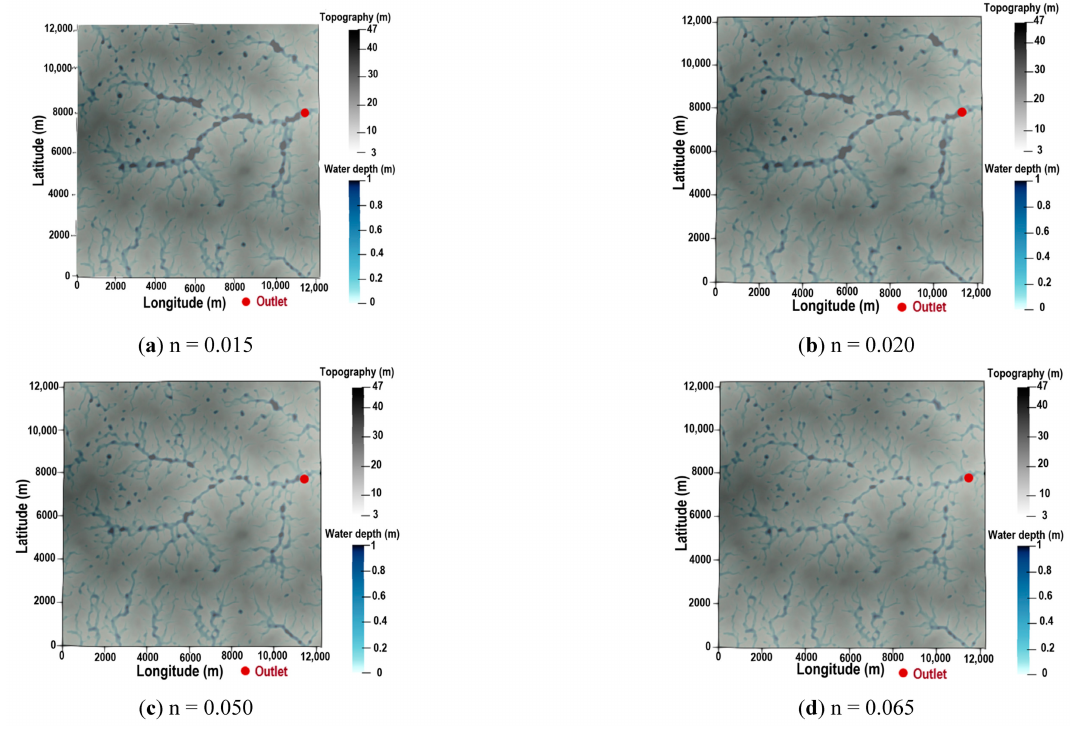
Figure 6. Flood maps for various values of roughness coefficient.